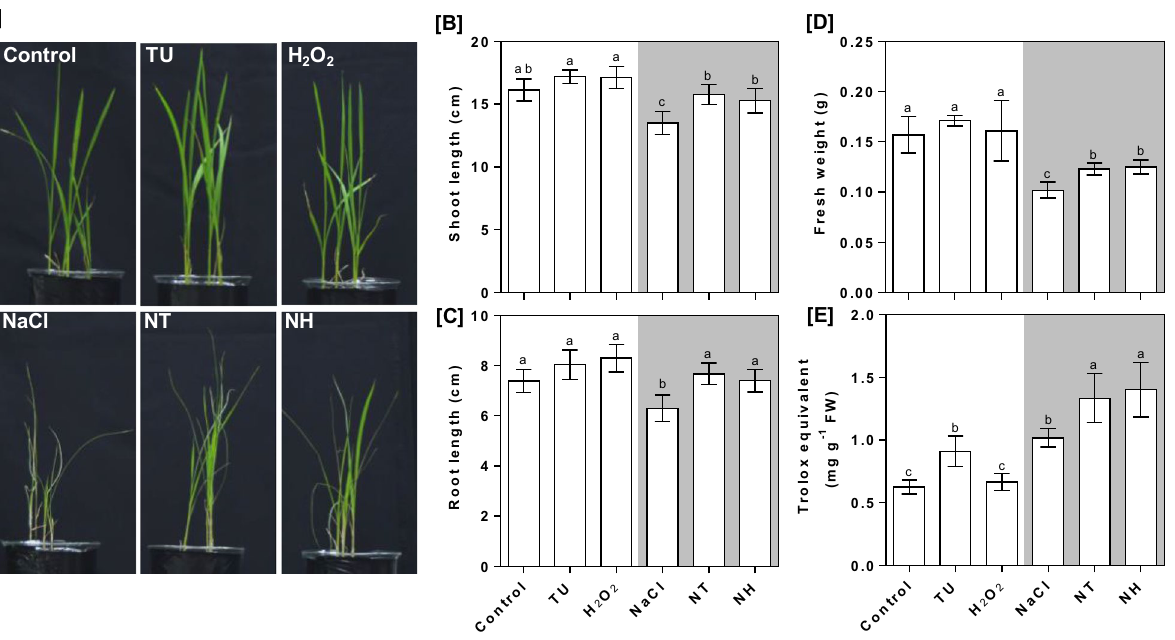
Figure 1. Post-germination phenotyping of rice seedlings under different treatments. The rice seedlings were grown hydroponically for 14 days under control conditions and then, subjected to different treatments including control (Yoshida medium), NaCl (50 mM), TU (7.5 µM), NaCl (50 mM) + TU (7.5 µM) [NT], H 2 O 2 (1 µM) and NaCl (50 mM) + H 2 O 2 (1 µM) [NH]. After 7 days of treatment, differential phenotyping was observed qualitatively ( A ) and also quantified in terms of shoot length ( B ), root length ( C ), seedlings fresh weight ( D ). In addition, the total antioxidant capacity as trolox equivalent was also quantified from shoot part ( E ). For NT and NH, 24 h pretreatment of 7.5 µM TU and 1 µM H 2 O 2 , respectively was also given. All the values are mean of triplicates ± SD. Different letters indicate significantly different values (DMRT, p ≤